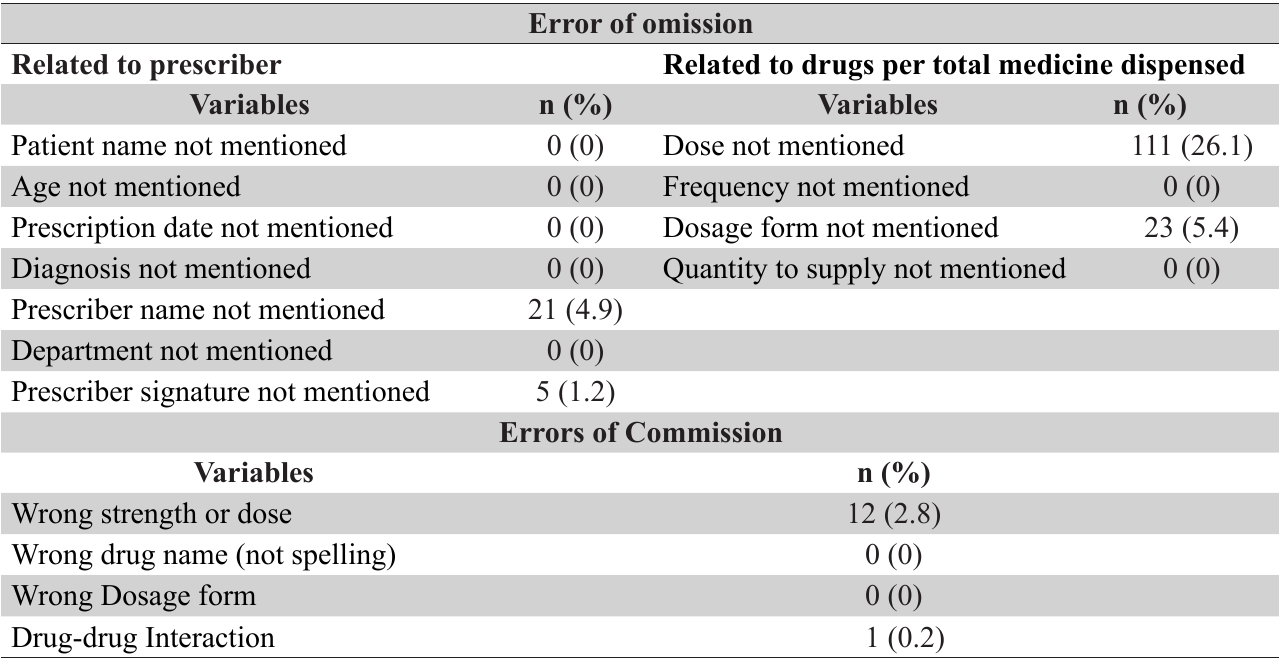
Table 2. Distribution of prescriptions errors among patients (N = 425)